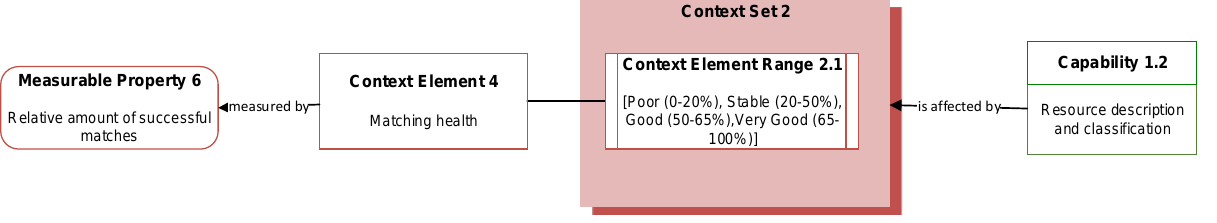
Figure 2. Excerpt from the CDD model depicting context